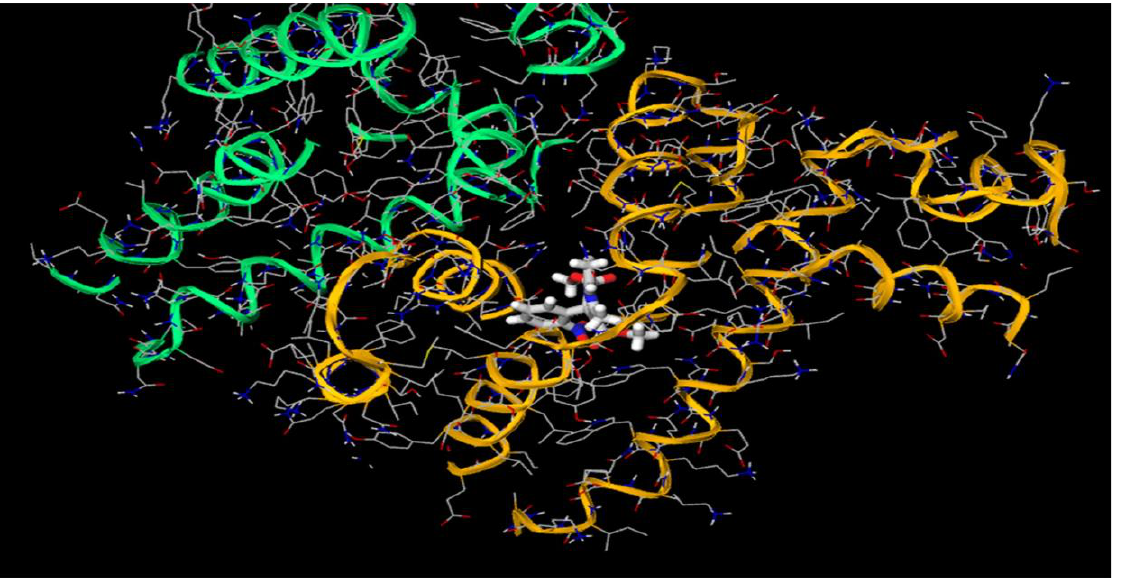
Figure 4. Pose for binding of nifedipine to the HTH-type transcriptional regulator